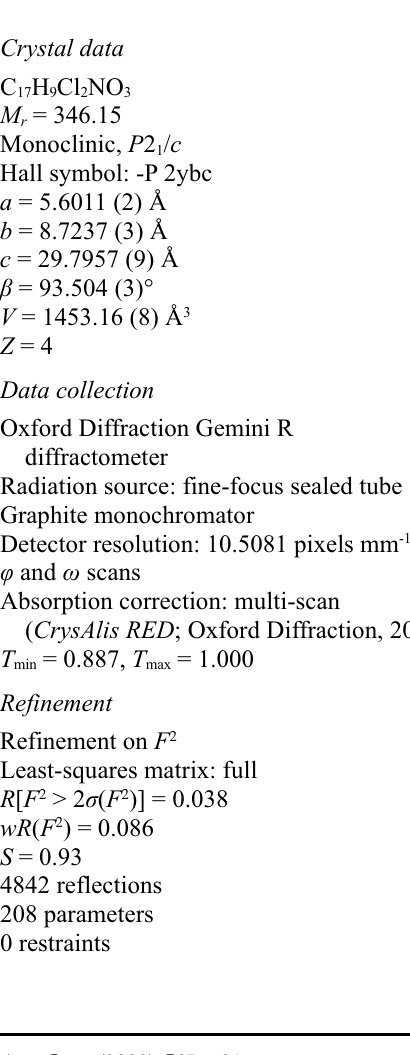
Figure 2 View of the packing viewed down the a axis. Dashed bonds show weak C—H···O interactions.